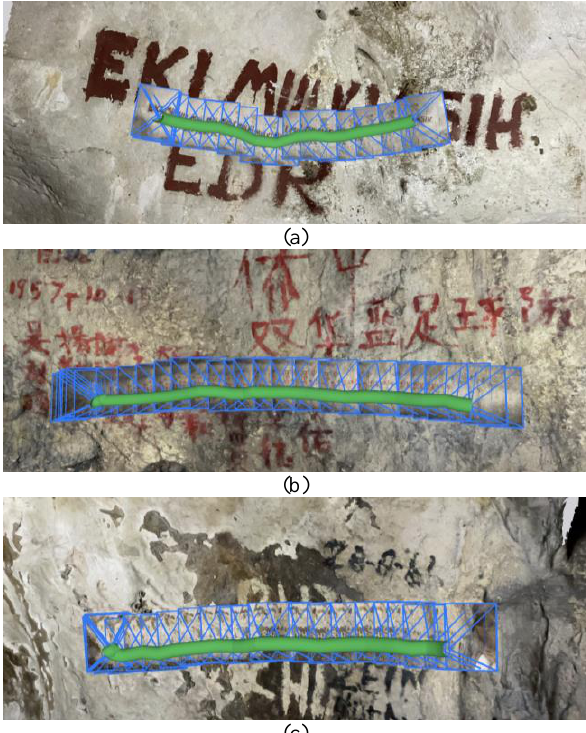
Figure 2 . Scan path illustrations for all applications obtained from the 3D Scanner